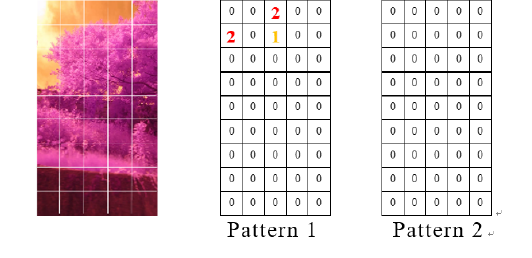
Figure 25. Transition of target trees